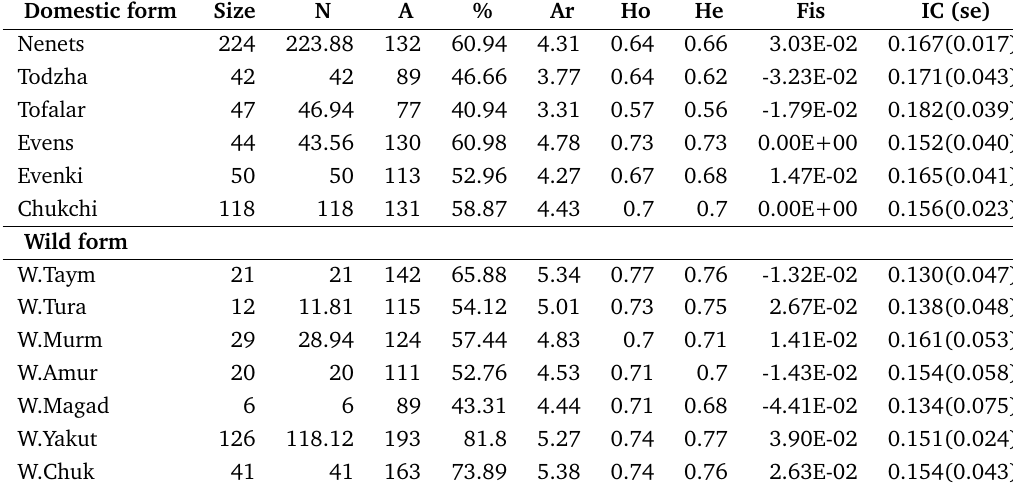
Table 2. Population parameters for the domesticated and wild reindeer samples studied. Size: population sample size; N: the average number of animals genotyped per marker; A: the number of alleles per sample; %: the percentage of total alleles observed across population samples per population sample per locus; Ar: the mean allelic richness across markers; Ho and He: observed and expected heterozygosity, respectively; Fis: fixation index; IC(se): mean (standard error) of inbreeding coefficients estimated for all animals. Herds of wild reindeer from Taimyr, Tura, Murmansk, Amur, Magadan, Yakutia and Chukotka are designated as ’W.Taym’,